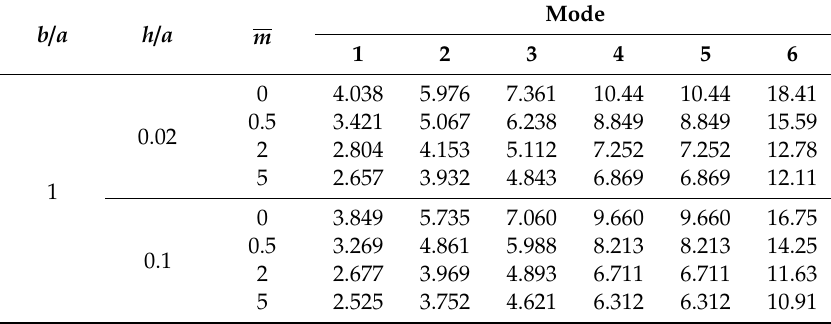
Table 8. Nondimensional natural frequencies Ω of FFFF Al / Al 2 O FGM rectangular